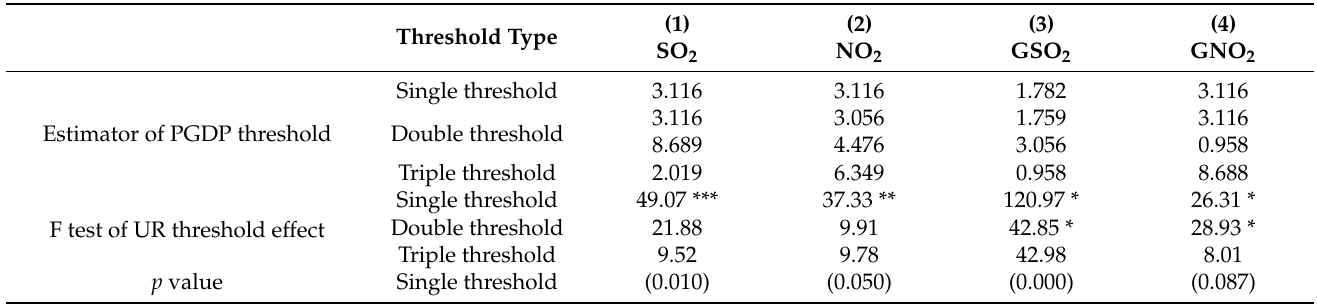
Table 3. Model specification test results.